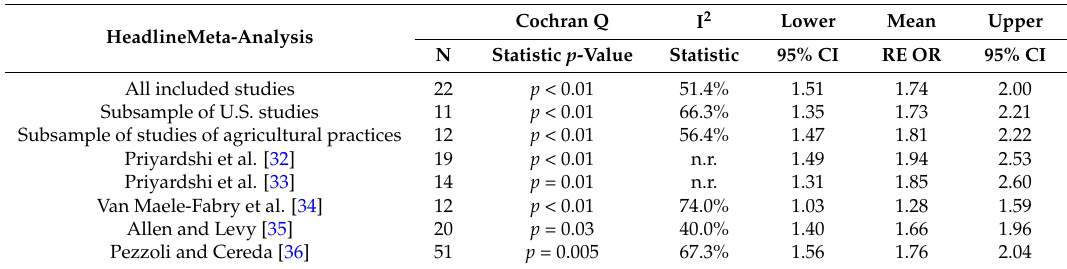
Table 3. Meta-Analysis